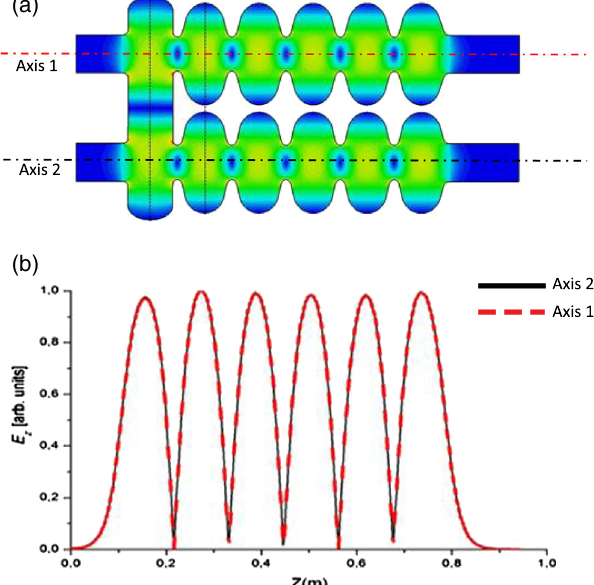
FIG. 1. (a) A schematic of the 11-cell rf cavity with a contour plot of the E z field component (accelerating field) of the operating mode; (b) the dependence of the absolute value of the E z field (operating mode) on the longitudinal coordinate z . The corresponding relationships are shown for both axes of the cavity (solid and dashed